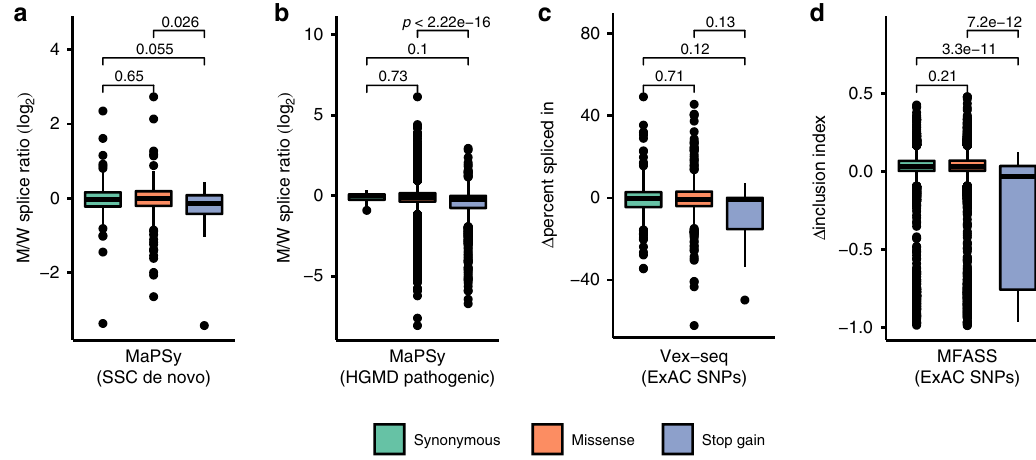
Fig. 3 Stop gain mutations are the most disruptive to splicing function. Relationship between a mutation ’ s effect on splicing ( y axis) was plotted for progressively more disruptive categories of protein disruption (synonymous < missense < stop gain) based on data from four high-throughput splicing assays. a Boxplot of MaPSy M/W splice ratios for a panel of de novo mutations from the Simons Simplex Collection (SSC) ( n = 192 synonymous, 413 missense, 31 stop gain variants). M/W splice ratios were derived from mutant and wild-type read counts in a high-throughput splicing assay, based on summed read counts over two input sequencing and four output transfection replicates. b Boxplot of MaPSy M/W splice ratios for previously studied pathogenic variants from the Human Gene Mutation Database (HGMD) ( n = 8 synonymous, 2877 missense, 822 stop gain variants). c , d Boxplots for measures of splice disruption for single nucleotide polymorphisms (SNPs) from the Exome Aggregation Consortium (ExAC) previously studied using c Vex-seq ( Δ percent spliced in, n = 244 synonymous, 520 missense, 18 stop gain variants) and d MFASS ( Δ inclusion index, n = 4416 synonymous,